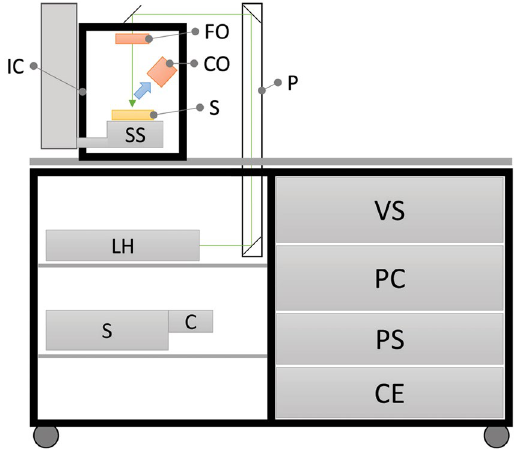
Figure 7. Schematic diagram of Sci-Trace (AtomTrace, CZ), where LH: laser head, S: spectrometer, C: camera/ detector, VS: vacuum system (gas purge), PC: computer, PS: laser power supply, CE: control electronics, P: